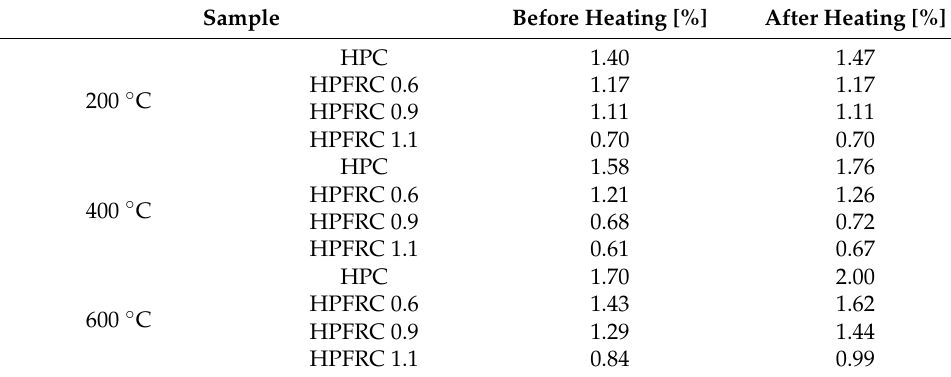
Table 2. Comparison of porosity before and after heating.